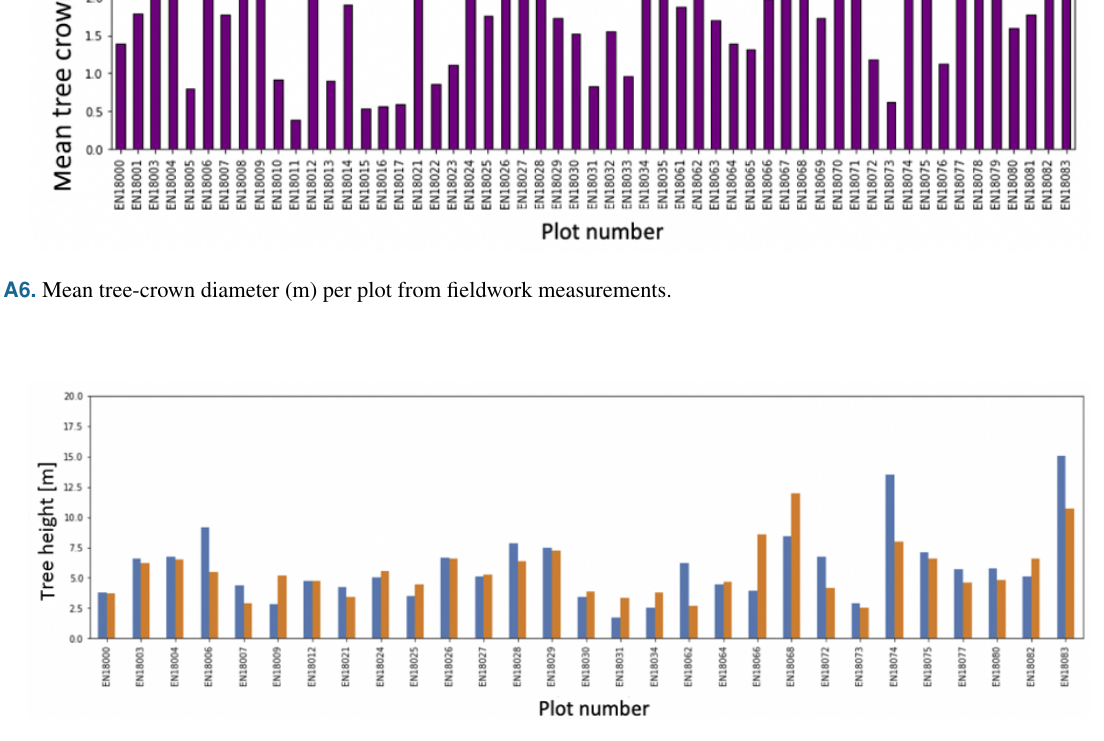
Figure A7. Mean heights for trees and shrubs below 1.3m for unmanned aerial vehicle (UAV)-derived heights (blue) and fieldwork-derived heights